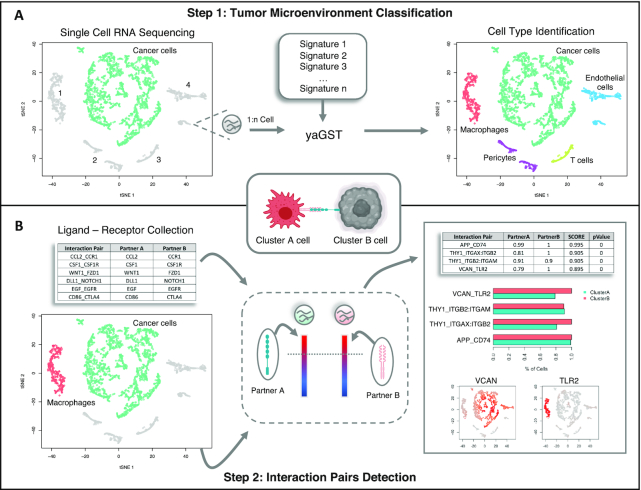
scTHI workflow. Description of scTHI functionalities. (A) In the first step a single sample enrichment analysis based on the Mann-Witney-Wilcoxon gene set test (mww-GST) [39] with a collection of 295 gene immune and stromal signatures is used to nominate the identity of cells of the microenvironment. (B) In the second step, given 2 clusters of cells, the most significant L–R interactions are identified by assigning a score to all 2,548 collected pairs of ligands and receptors.